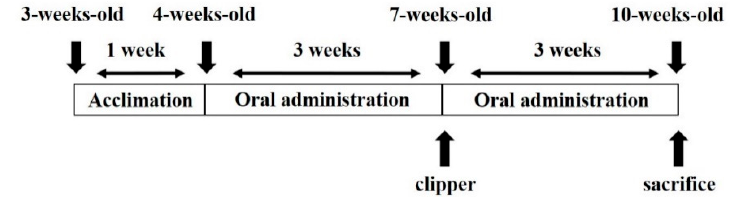
Figure 8. Timeline of experimental treatments and sample collection.